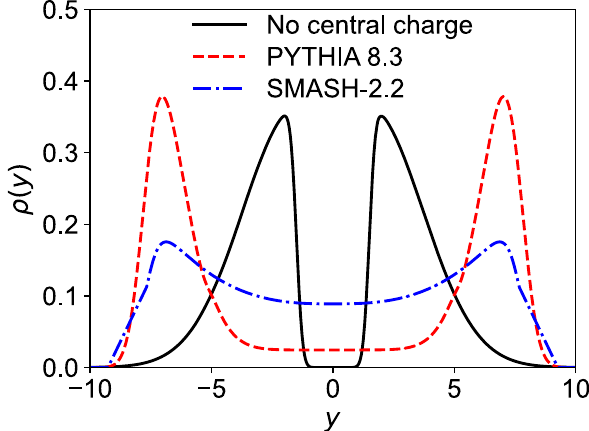
Fig. 1 Net-proton rapidity distributions for the 3 scenarios described in the text